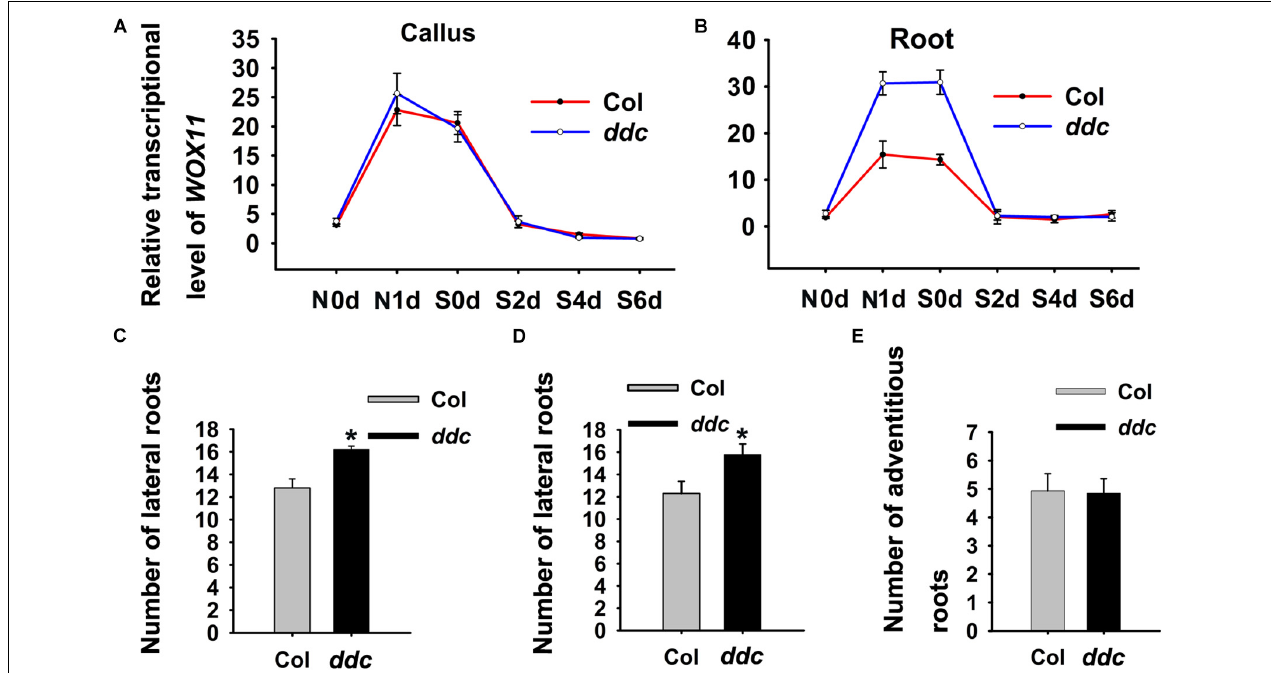
FIGURE 8 | Dynamics of WOX11 transcript levels in hypocotyl (A) and root (B) explants derived from ddc and wild-type seedings. (C) Lateral root numbers derived from ddc and wild-type seedlings grown on hormone-free medium. (D) Lateral root numbers of ddc and wild-type explants after 48 h NAA-treatment. (E) Adventitious root number of ddc and wild-type hypocotyls which were cultured in hormone-free medium after 48 h NAA-treatment. Error bars show standard deviations of three biological repeats. *0.001 < P < 0.01 are determined by two-tailed Student’s t